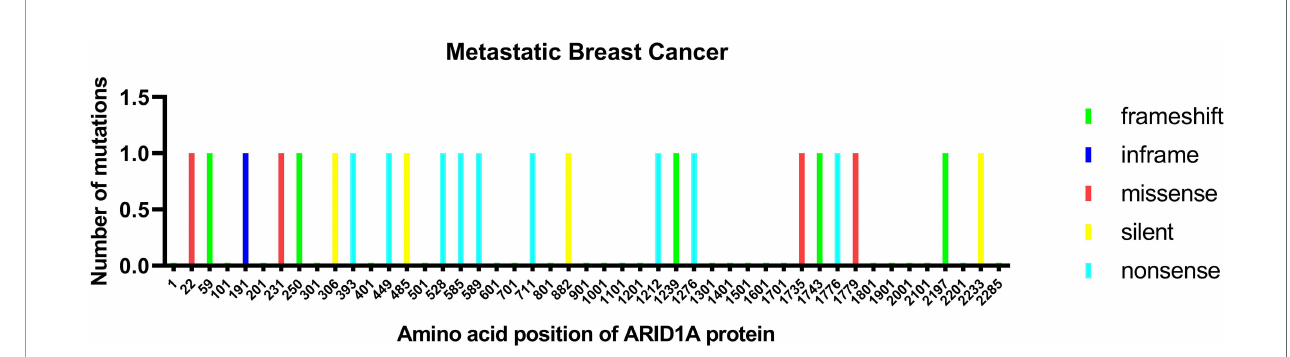
FIGURE 1 | ARID1A protein mutation in metastatic breast cancer. The mutations are colored by the type of mutations: missense, nonsense, silent,